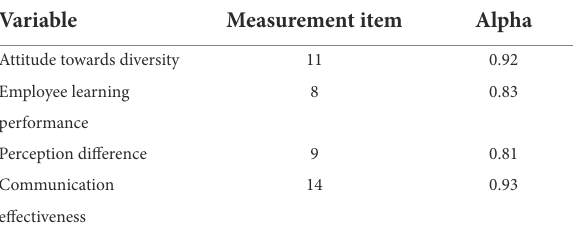
TABLE 2 Reliability analysis results of measurement scale.